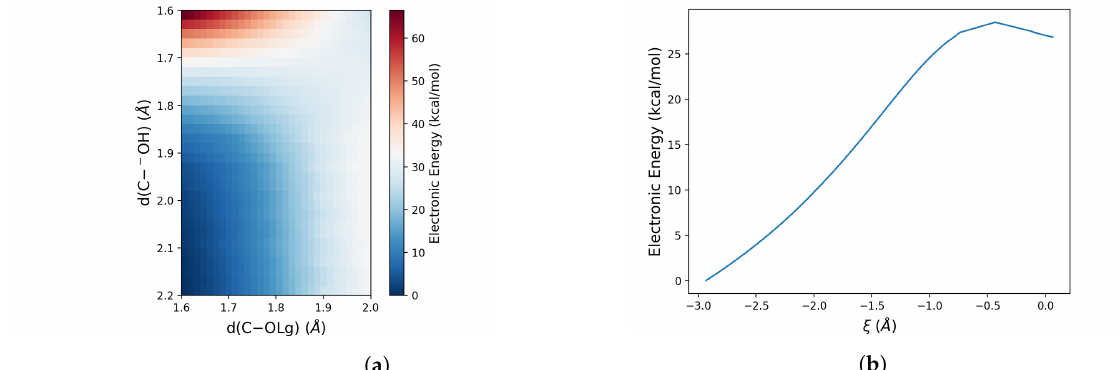
Figure 3. ( a ) Bi-dimensional scan performed along the hydroxide oxygen atom–carbon atom and the carbon atom –leaving group oxygen distances; ( b ) Gas phase electronic energy profile along the reaction coordinate ξ (defined as the difference between the HO − –P and the P–OLg distances).